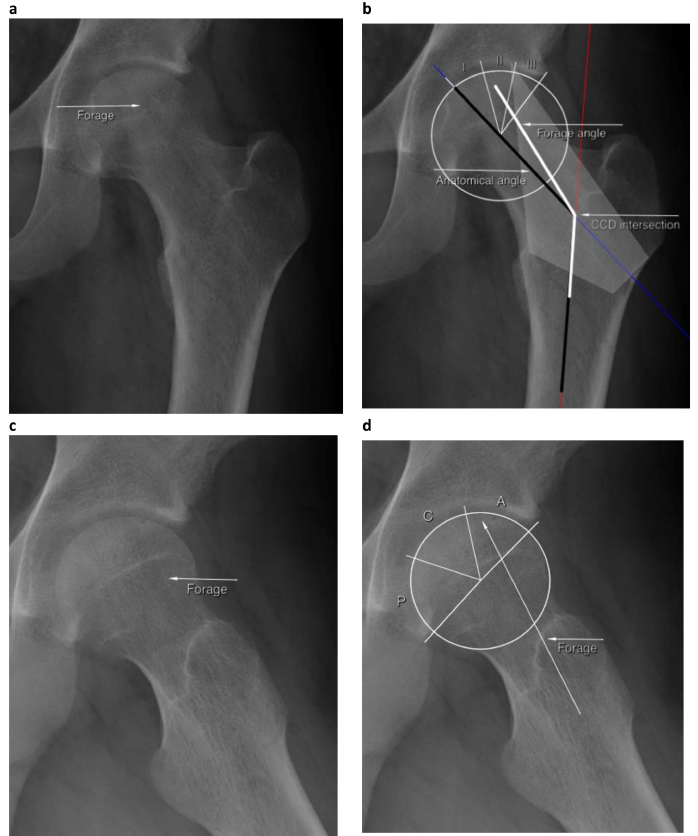
Figure 4. Forage location in postoperative radiographs at 1.5 months after surgery, case 103, showing ( a ) forage drilling in AP radiograph, and ( b ) the radiological measurements of the anatomical angle, forage angle and forage location in the second third of the weight-bearing area (WBA), using the Japanese Investigation Committee (JIC) 2001 staging. In ( c ), forage drilling in lateral radiograph, and ( d ) location of the forage in the anterior section of the femoral head, using the ACP